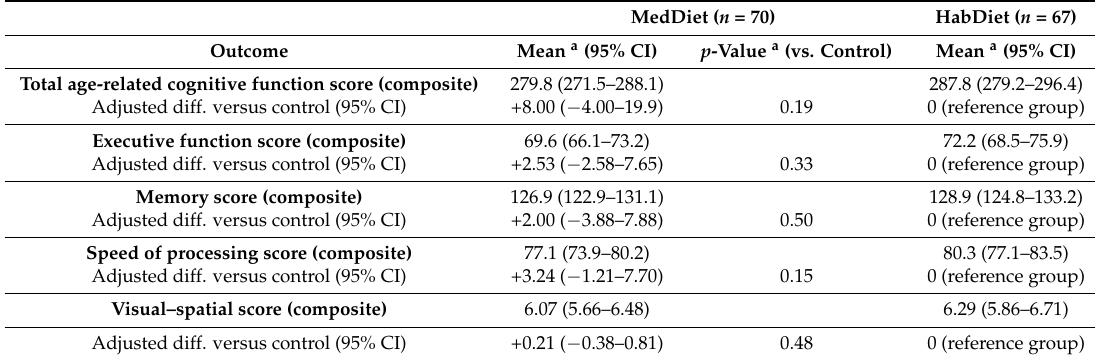
Table 4. Multivariable-adjusted mean differences between the MedDiet intervention group and control group (95%